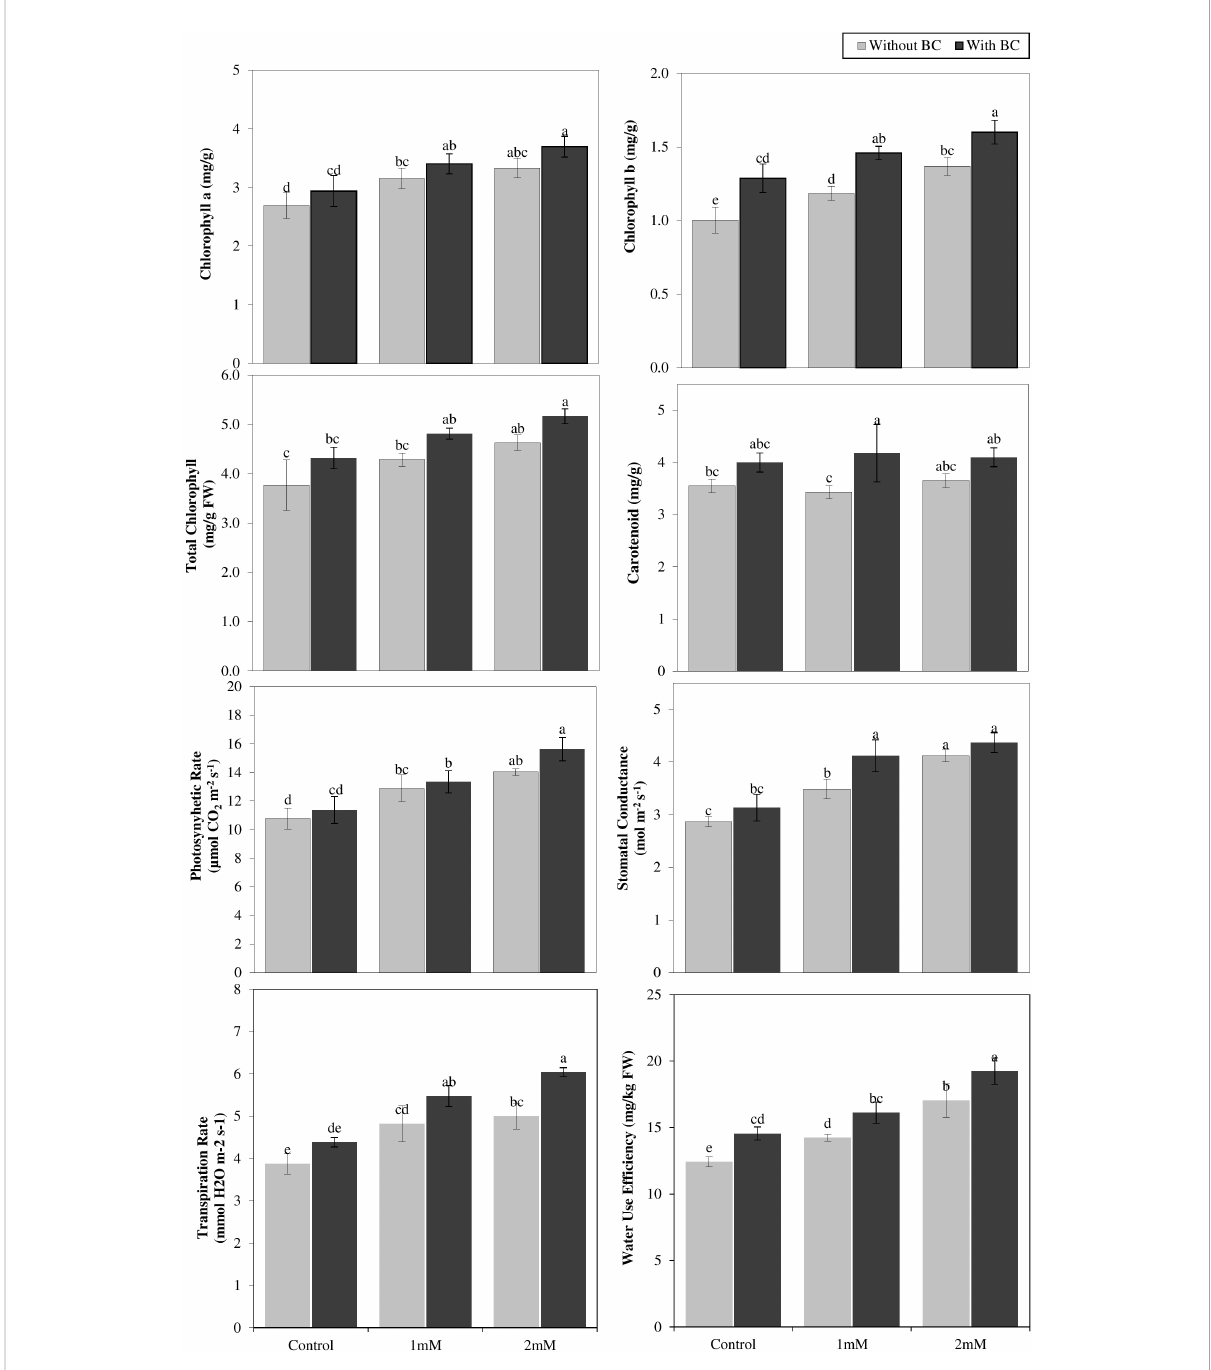
FIGURE 2 Data represent different levels of zinc – lysine (control 0, 1, 2 mM) with and without biochar on MDA, H 2 O 2 , EL, POD, SOD, APX, and CAT contents of wheat plant showing means of replicates (n=3) ± standard deviation. Different letters indicate signi fi cant differences by Tukey HSD test at p ≤